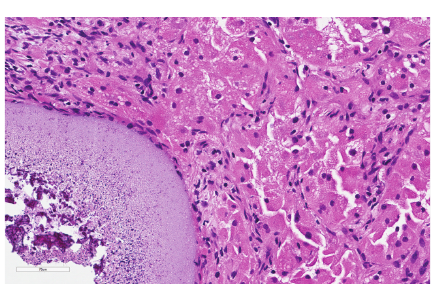
Figure 4: Colocalization of metastatic renal cell carcinoma and a trisacryl gelatin microembolus. The embolus is shown in the left lower corner (hematoxylin-eosin, original magnification ×